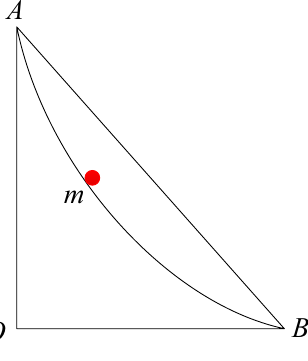
Figure 1. Schematic diagram of the